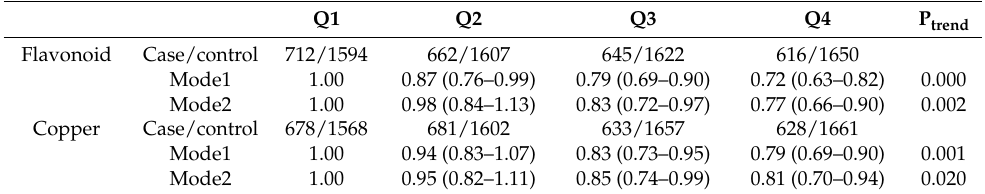
Table 3. Odd radios (ORs) and 95% confidence intervals (CIs) of MetS risk scores by quartile of energy-adjusted flavonoid and copper